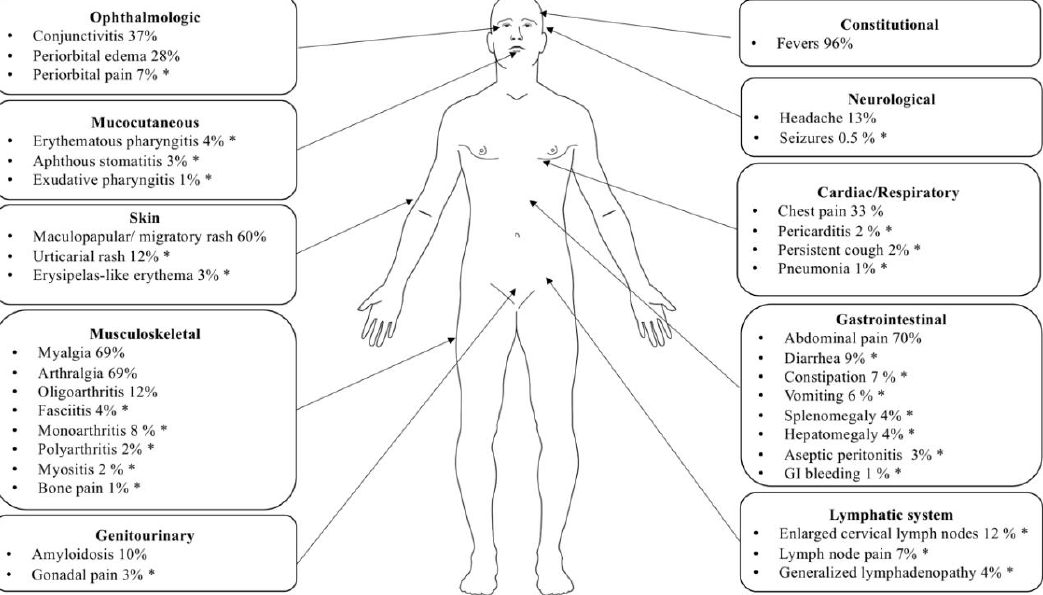
erythematous rash (60%), abdominal pain (70%), acute conjunctivitis (37%), periorbital edema (28%),